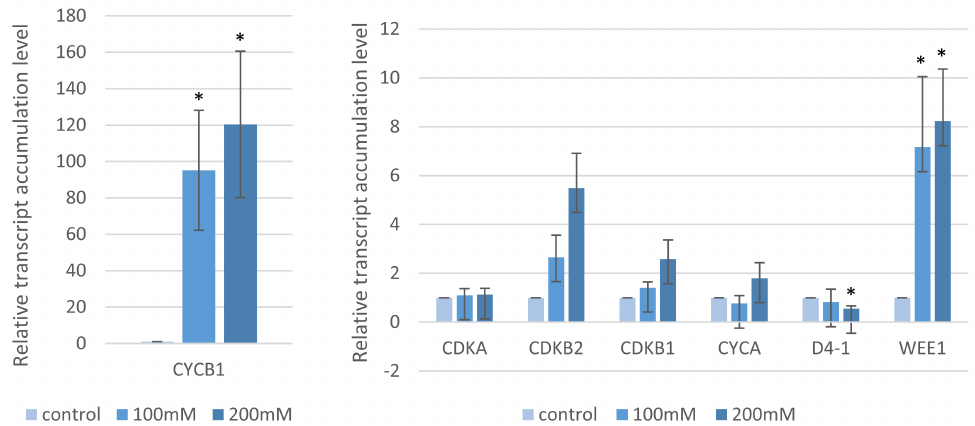
Figure 7. Relative level of the accumulation of the cell cycle gene transcripts after “salt stress” treatment with various concentrations of NaCl. Relative expression levels were normalized to an internal control (Bradi1g32860; encoding ubiquitin) and calibrated to the control. Asterisks indicate significant differences from the control using the Student’s t -test ( p < 0.05; mean ± SD, n = 3).